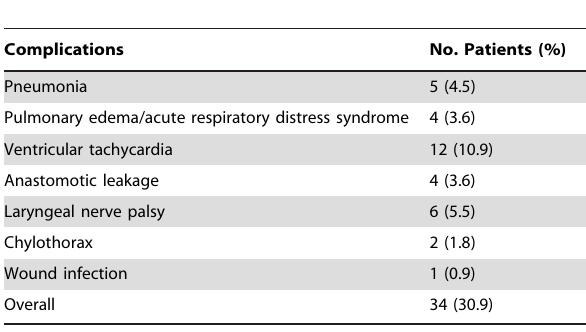
Table 2. Postoperative morbidity for 110 patients undergoing